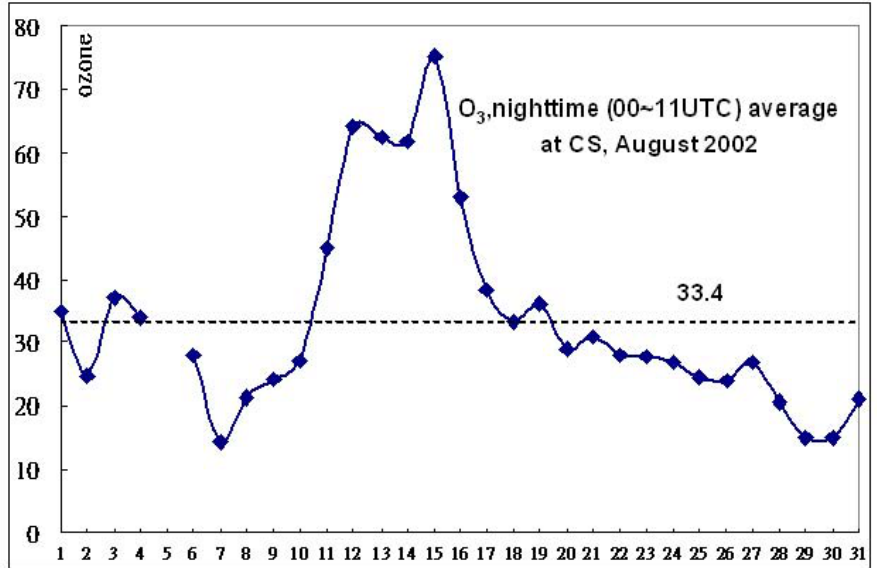
Figure 4. Ozone averages during nighttime (00-11UTC) during 1–31 August 2002 at CS. The dotted line is the monthly-nighttime-average of August.